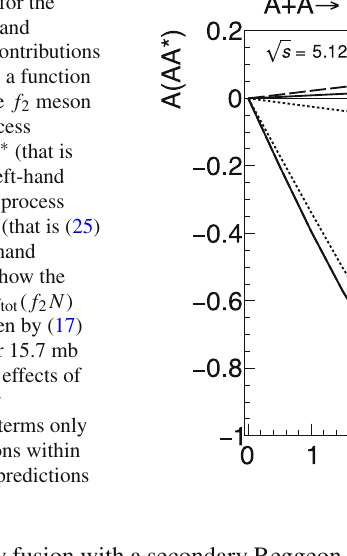
Fig. 4 Predictions for the Pomeron–Pomeron and γ -Odderon fusion contributions to the asymmetry as a function of the rapidity of the f 2 meson produced in the process AA → A + f 2 + A ∗ (that is (26) plotted in the left-hand diagram) and in the process pA → p + f 2 + A (that is (25) plotted in the right-hand diagram). We also show the effect of changing σ tot ( f 2 N